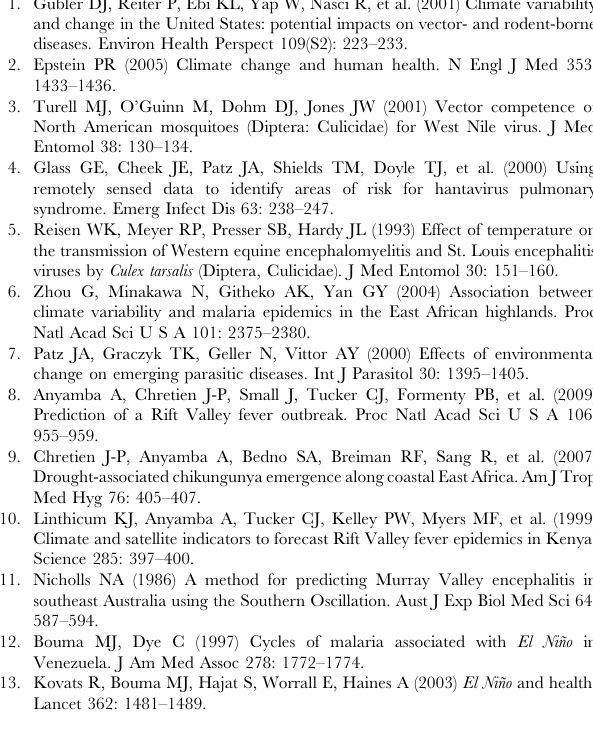
Figure S2 SST anomalies during the peak of the La Nin˜a event from December, 2007–February, 2008. Global seasonal equatorial sea surface temperature anomalies during the